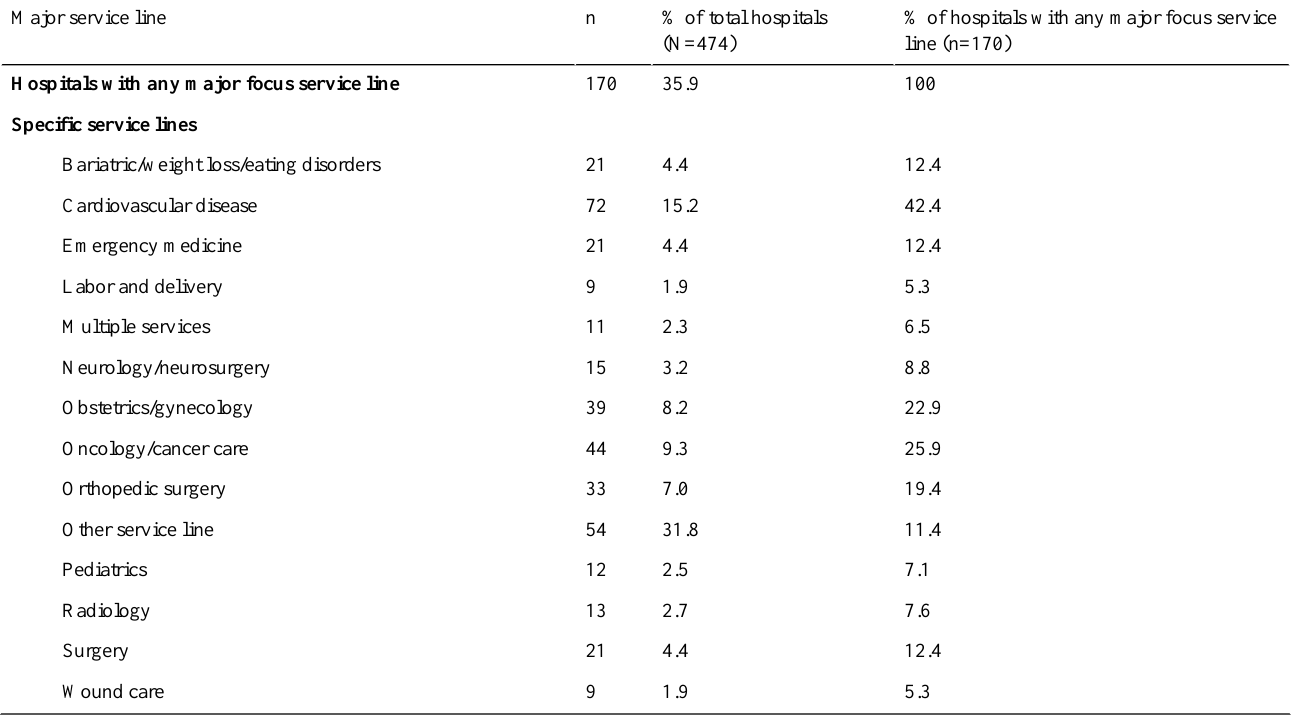
Table 4. Hospital websites with a major focus on service lines.